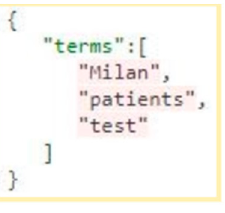
Figure 7. Data consumer query terms.